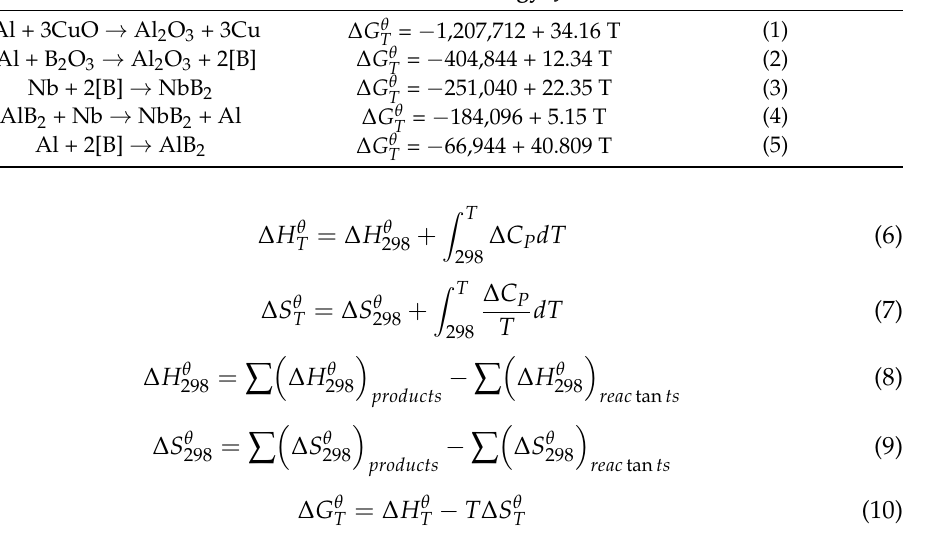
Table 1. The relationship between Gibbs free energy and temperature [17–19]. Chemical